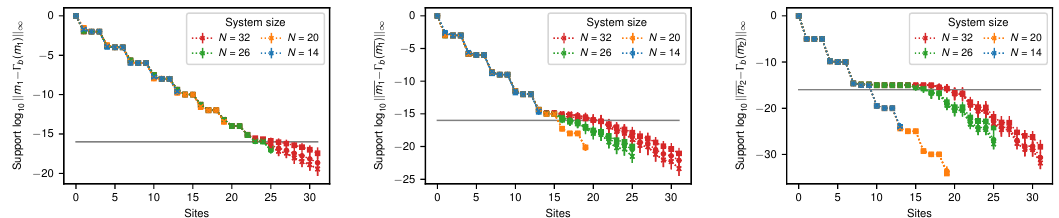
Figure 3: Finite size scaling for the non-interacting ( η = 0) algorithm and the m mode. Color encodes system size, the gray line indicates machine precision. Each point is an average over 100 realizations. The different panels show interaction strength J = 10 − 2 ,10 − 3 ,10 − 5 from left to right. The three values of disorder ∆ = 0.1,0.3,0.5 are indicated by markers and either lie on top of one another or are below machine